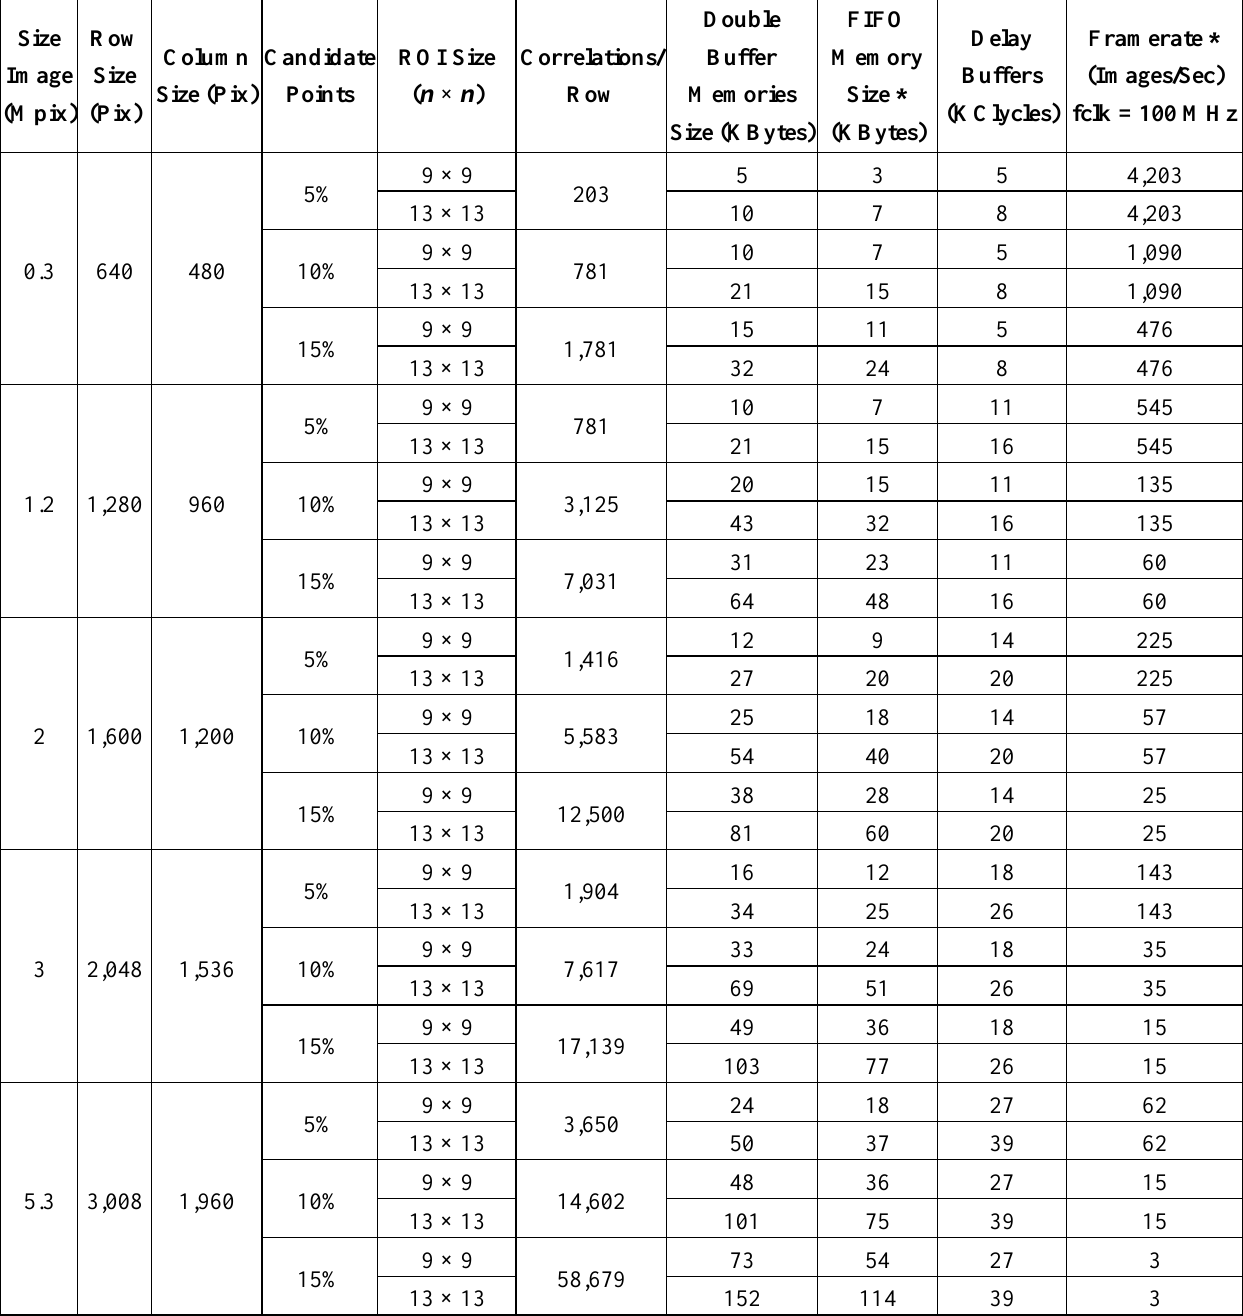
Table 1. Design parameters and resource